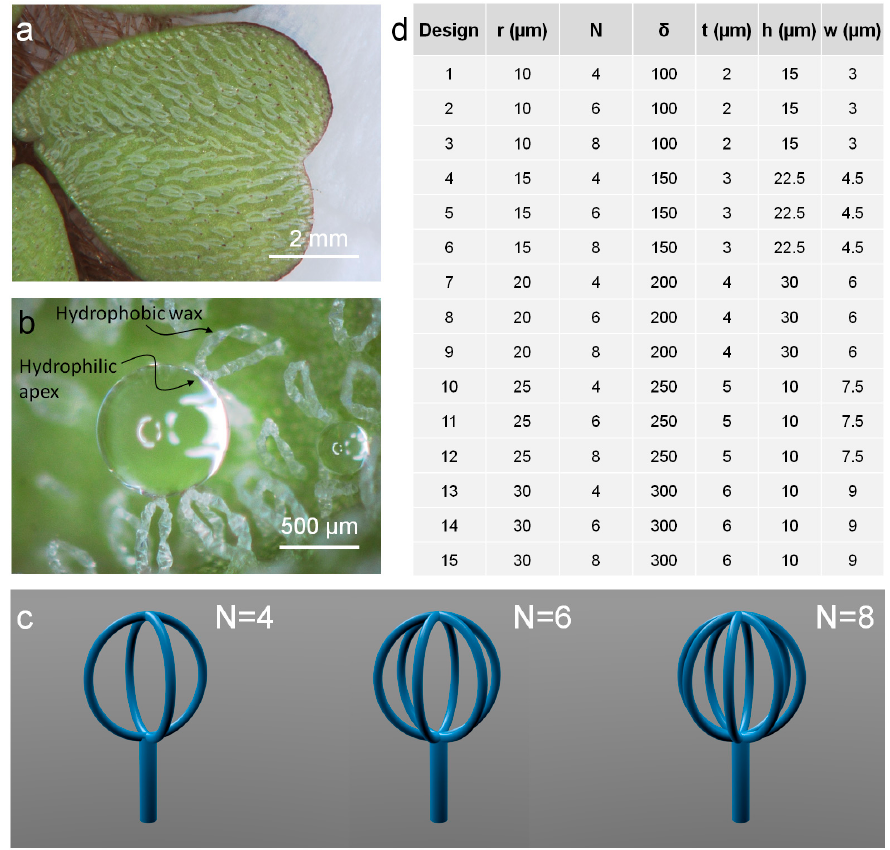
Figure 1. ( a ) Pattern of ‘eggbeater’ hairs that cover the upper side of the Salvinia molesta leaves; ( b ) Interaction of the hairs with a droplet water, showing the hydrophilic apex able to pin the droplet, while the remaining structure is hydrophobic; ( c ) Three different designs for the crown-like heads tested in our work consisting of four, six, and eight filaments obtained by the intersection of two, three, and four circumferences rotated by 90°, 60°, and 30° respectively; ( d ) Table with all the 15 designs studied for air retaining: r is the radius of the head, N the number of its filaments, δ is the number of parallel circumferences actually exposed to the laser beam for the fabrication of the filaments, t is their actual thickness, h is the height of the stalk, and w is its diameter.